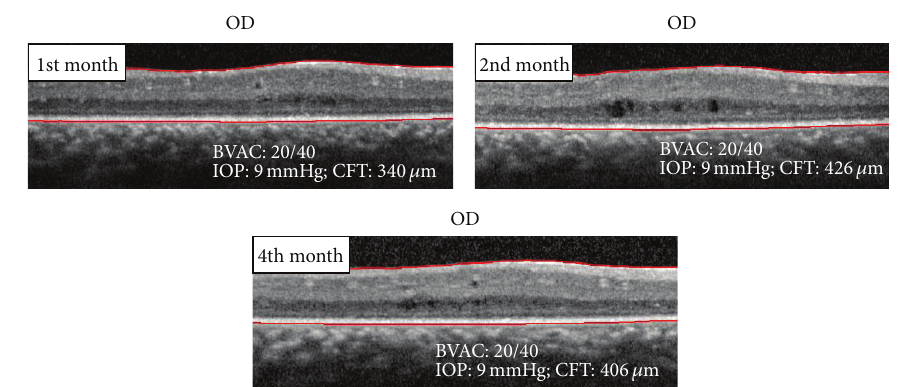
Figure 8: OCT spectral domain OD after subtenon depot